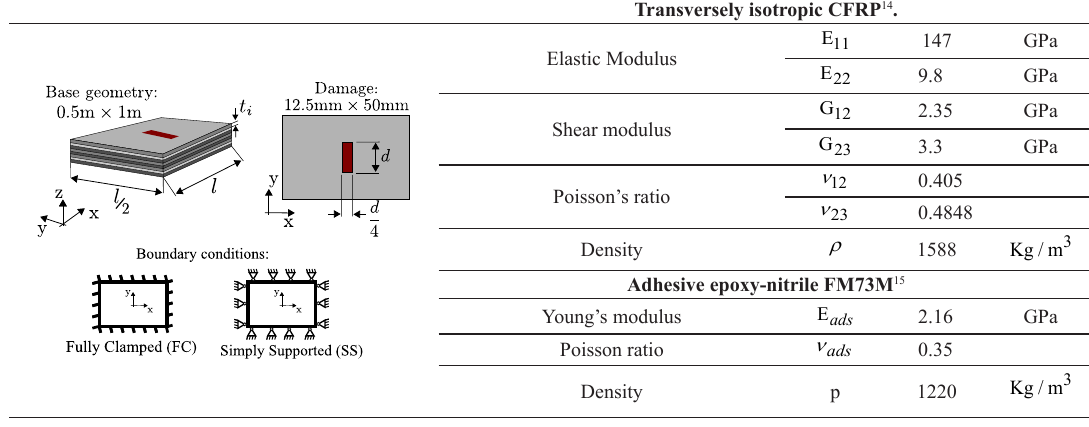
Repair Shapes Elliptical Patch design variables, i x :